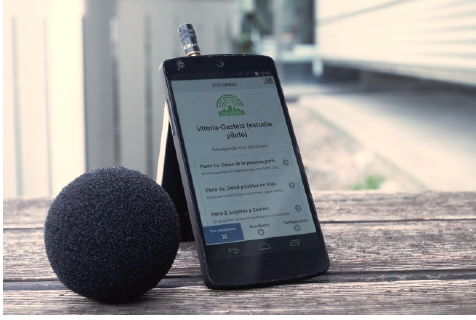
Figure 1. CITI-SENSE observation toolkit.